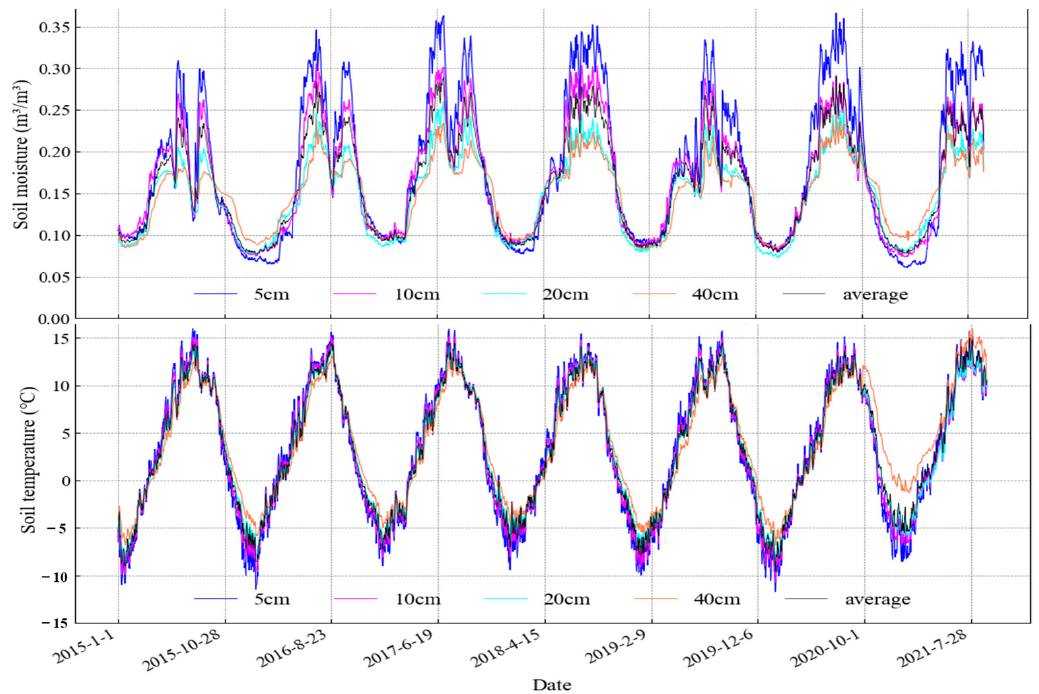
Figure 2. Naqu soil moisture and temperature measurement data for 2015–2021.